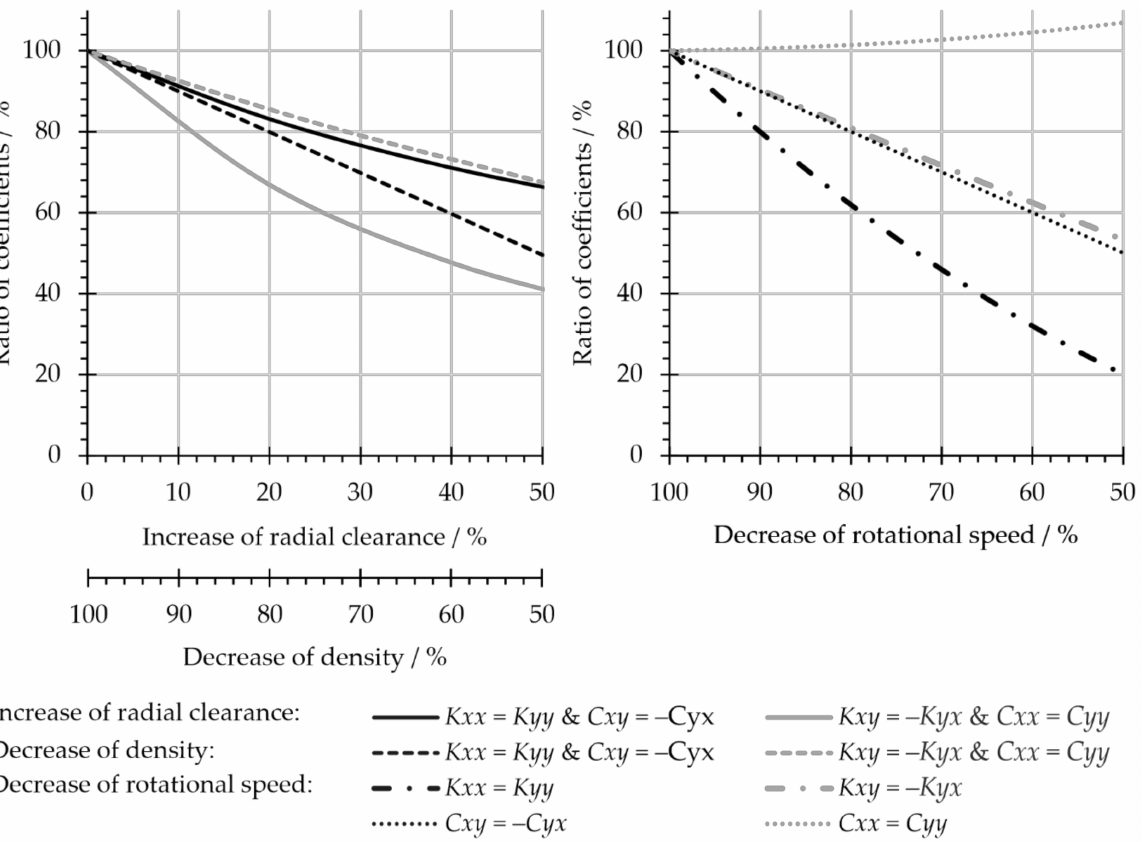
Figure 5. Ratio of stiffness and damping coefficients for decrease of rotational speed, increase of radial clearance and decrease of density in generator cavity of sCO2-HeRo M